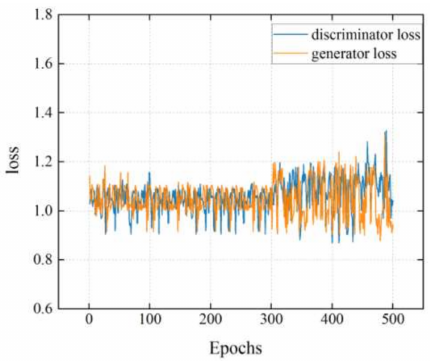
Figure 5. The loss value of the DCGAN